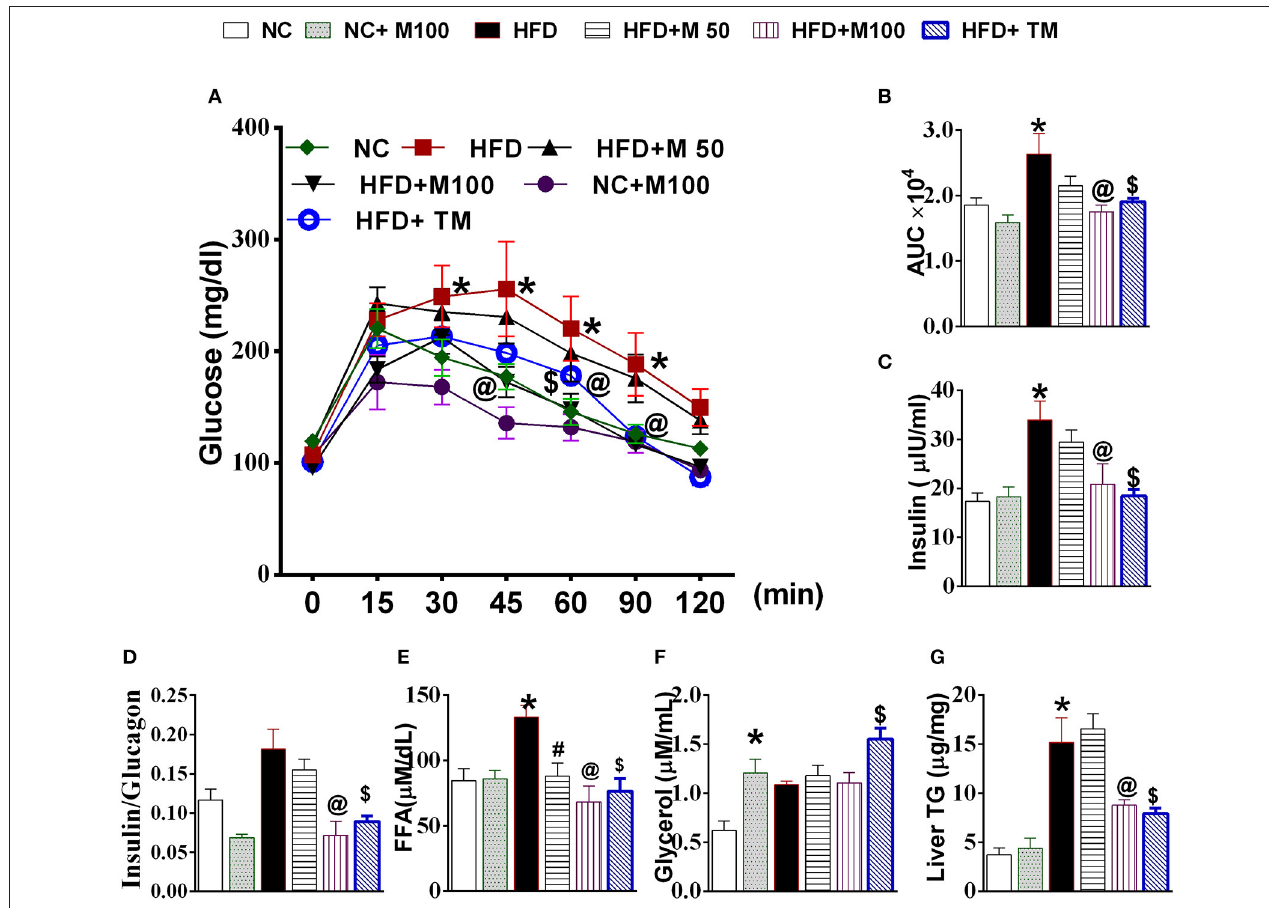
FIGURE 4 | Effect of chronic administration of oral and topical menthol on glucose clearance, hepatic fat deposition, and related parameters. (A) oral glucose tolerance test; (B) Area under the concentration-time curve (AUC) during OGTT test; (C) fasting serum insulin (ELISA); (D) insulin:glucagon ratio; (E) serum FFA; (F) serum glycerol; (G) liver triglyceride. NC, normal rodent chow fed; HFD, high fat diet fed; HFD + M50, HFD fed plus daily administration of 50 mg/kg menthol ( p.o. ); HFD + M100, HFD fed plus daily administration of 100 mg/kg menthol ( p.o. ); NC + M100, NC fed plus daily administration of 100 mg/kg menthol ( p.o. ); HFD + TM, HFD fed plus daily application of 10% topical menthol. n = 5; All the values are expressed as mean ± S.E.M; Analysis was carried out by one way ANOVA followed by Tukey’s multiple comparison; * p < 0.05 HFD and NC + M100 vs. NC; # p < 0.05 HFD + M50 vs. HFD fed group; @ p < 0.05 HFD + M100 vs. HFD fed group; $ p < 0.05 TM vs. HFD fed